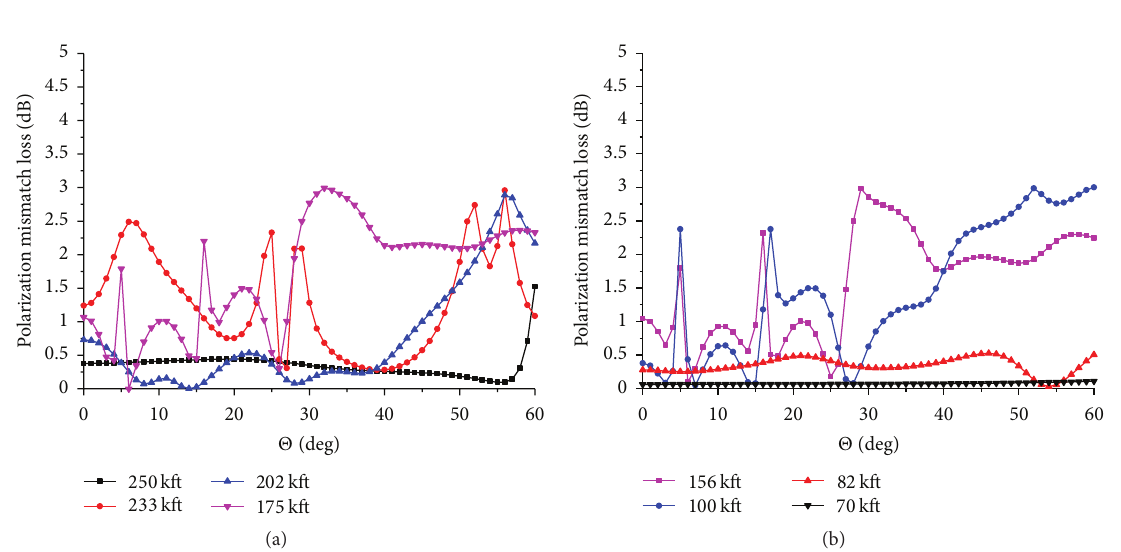
Figure 8: Polarization mismatch loss (plane of phi = 0 deg) at different